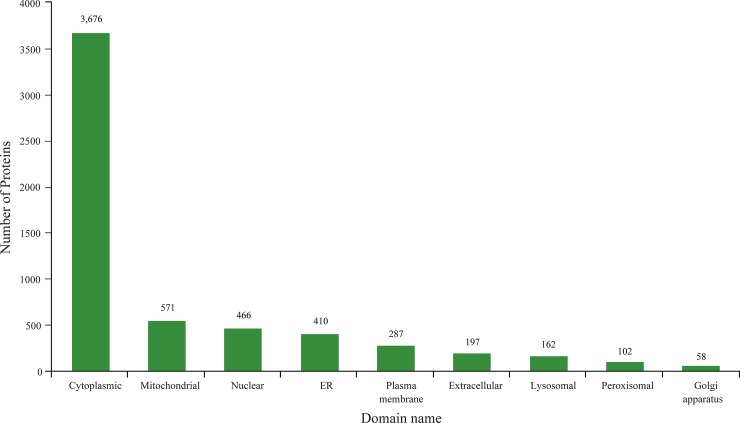
Prediction of protein subcellular localization.